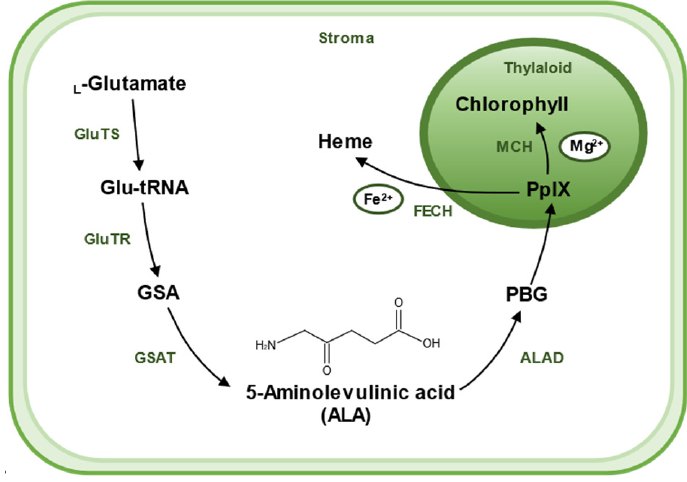
Figure 2. A sketch shows the biosynthetic pathway of ALA and the use of ALA as a substrate for the synthesis of chlorophyll and heme in plants. ALA is created in stroma of chloroplast. The main biosynthetic pathway of ALA is the Beal pathway, which starts from glutamic acid. L -Glutamate is ligated to tRNA Glu , which is catalyzed by glutamyl–tRNA synthetase (GluTS) to form L -glutamy– tRNA. Then, Glu-tRNA is converted to L -glutamic acid 1-semialdehyde (GSA), a reaction catalyzed by the key rate-limiting enzyme glutamyl–tRNA reductase (GluTR). GSA then undergoes an isomer- ization reaction catalyzed by glutamate-1-semialdehyde aminotransferase (GSAT) to form ALA. Two molecules of ALA are catalyzed by ALA dehydratase (ALAD) and agglomerate to form a pyrrole ring called porphobilinogen (PBG). Then, after a six-step enzymatic reaction, four molecules of PBG polymerize to form a porphyrin structure, eventually forming (PpIX). PpIX combines with different enzymes and substrates to yield different products; PpIX chelates Fe 2+ with Ferrochelatase (FECH) to produce heme, and Mg 2+ with Mg-chelatase (MCH), and then undergoes a series of catalytic reactions to produce chlorophyll.